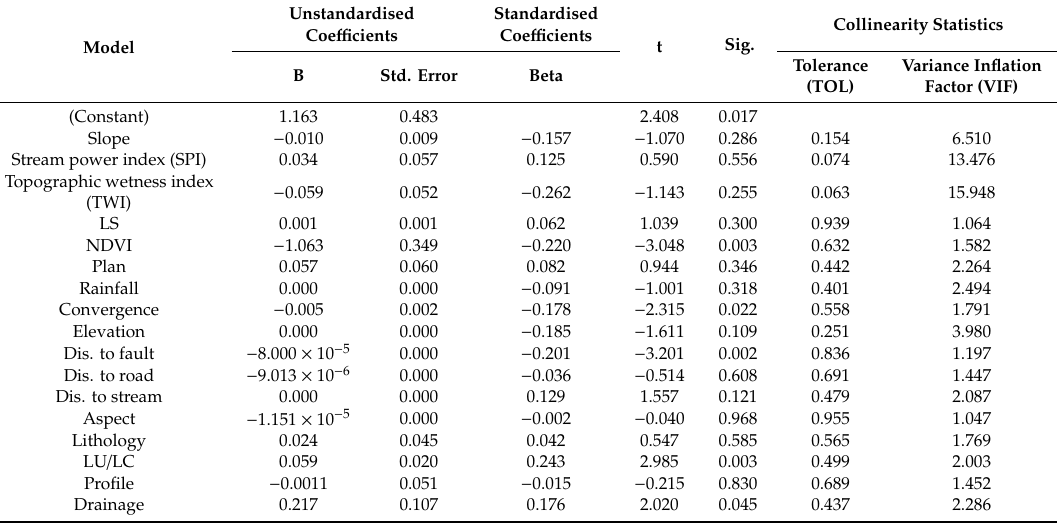
Table 3. Multicollinearity analysis among independent